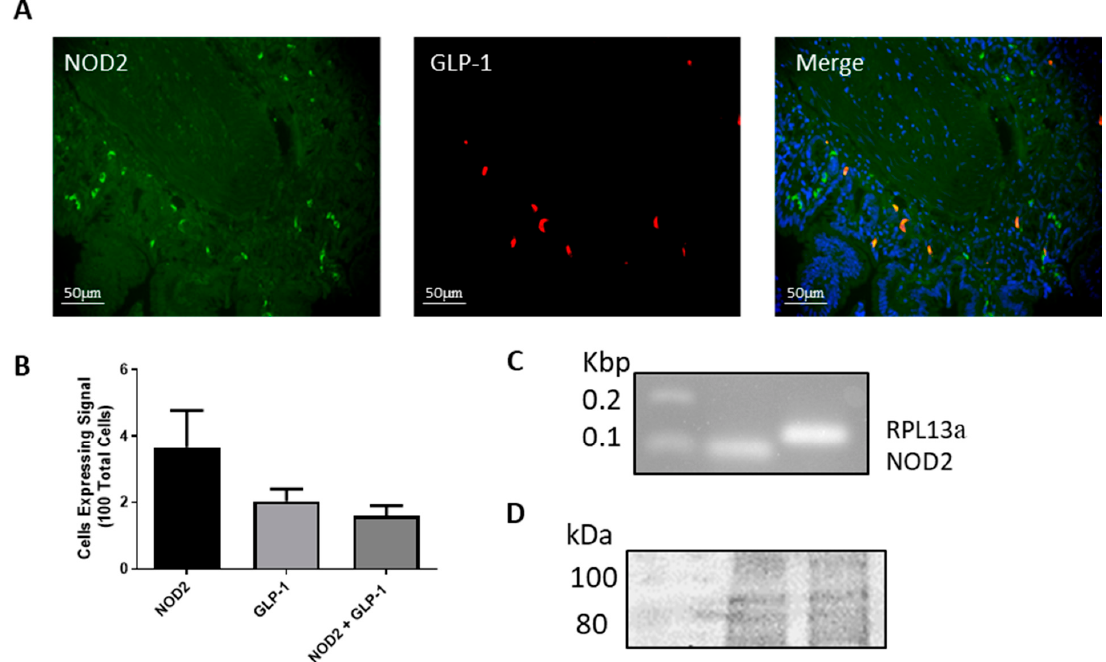
Figure 2. The nucleotide oligomerization domain 2 (NOD2) is expressed in L-cells. Ileum tissue was examined by fluorescent immunohistochemistry for NOD2 (green), GLP-1 (red) and nuclei (blue, in merge) ( A ). Cells expressing NOD2, GLP-1 or both were counted using 100 cells from four images to determine abundance within the ileum ( B ). mRNA expression of NOD2 and RLP13a was examined in GLUTag cells via RT-PCR ( C ). Protein expression of NOD2 in NCI-H716 cells via western blot (predicted size 97 kDa) ( D ).